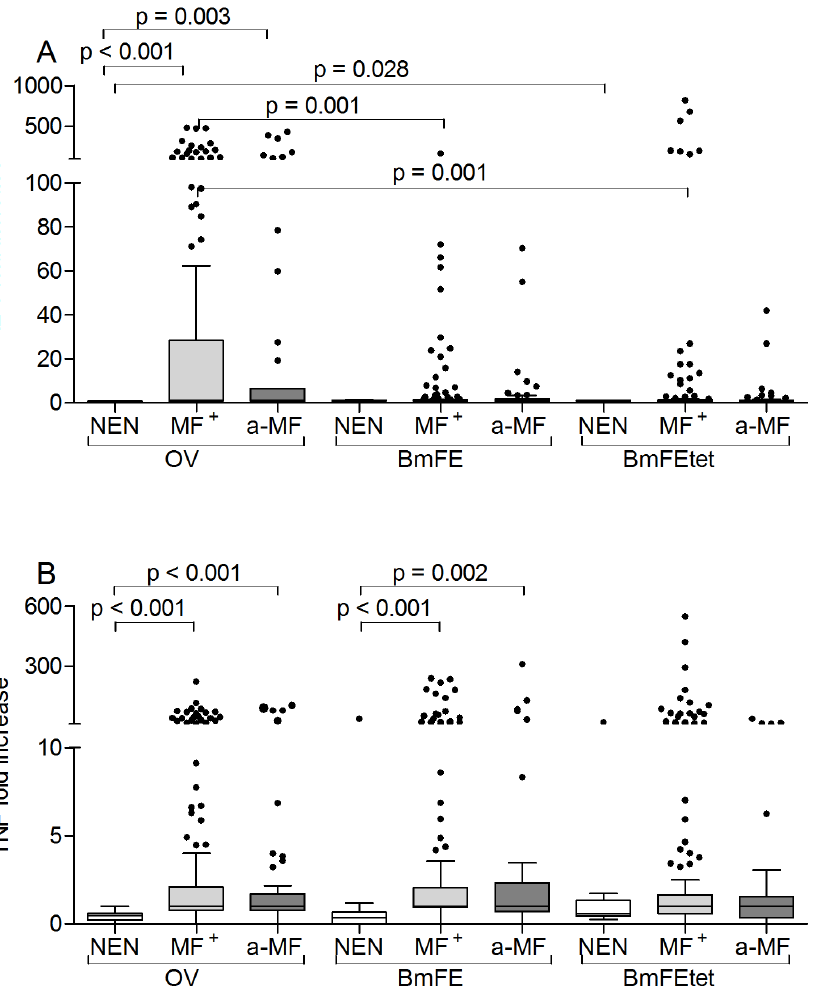
Figure 6. Increased O.volvulus -specific IL-6 and TNF responses in infected individuals. Isolated PBMCs (2 6 10 5 /well) from NEN or O. volvulus infected MF + or a-MF patients were stimulated with either OV extract, BmFE extract or BmFEtet extract. After 72 hours, levels of IL-6 (A) and TNF (B) were measured in the culture supernatants via ELISA. Data are plotted as fold increase over unstimulated controls. Graphs show box whiskers with median, interquartile ranges and outliers. Statistical significances between the indicated groups were obtained after Kruskal-Wallis and Mann- Whitney tests.